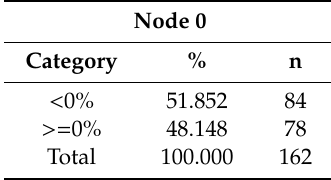
Table 9. The classification result for Node 0 in the decision